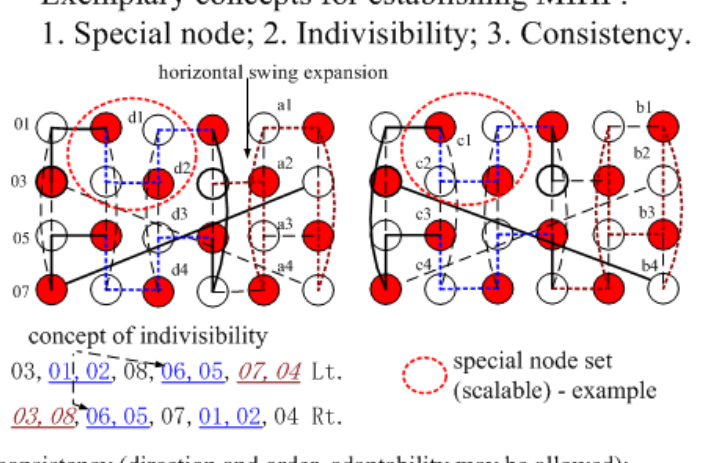
Figure 3. Mutually independent Hamiltonian paths (MIHP) performance exist in GHT(2,4,2) ( a ) without vertical extension (X-ext.); ( b ) with vertical extension